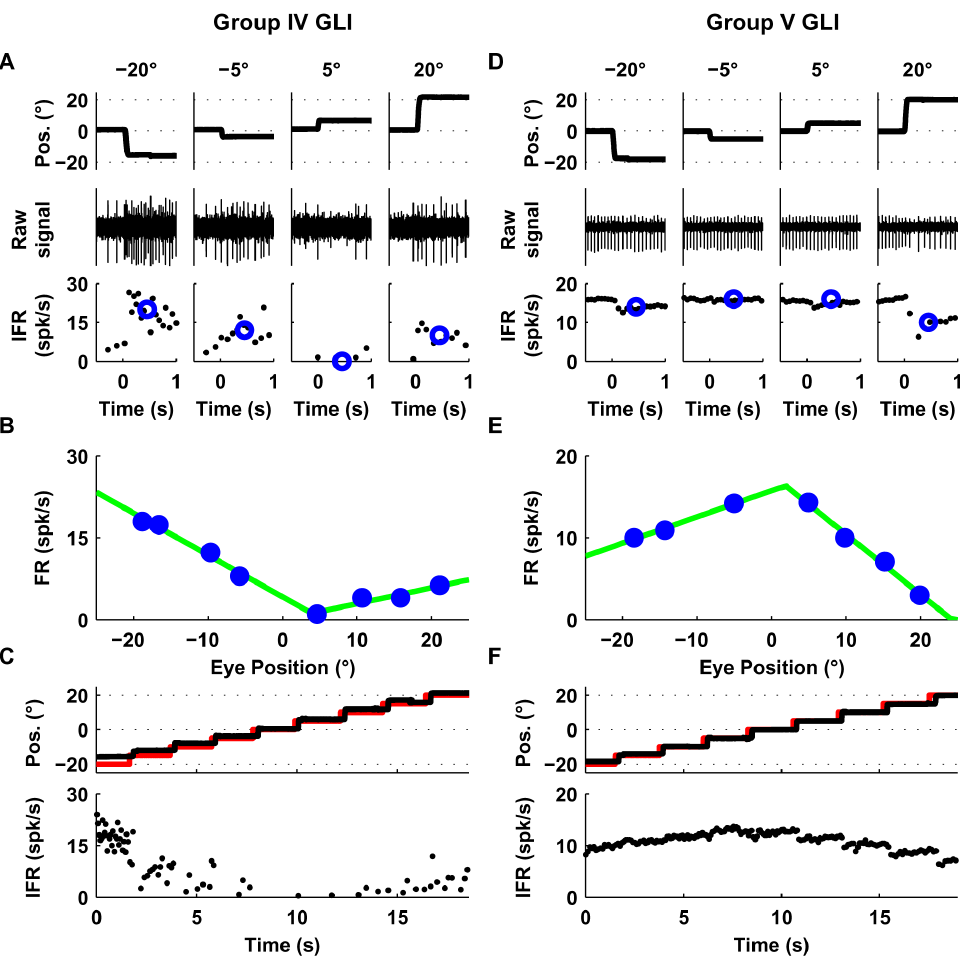
Figure 5. Responses of example Group IV (A–C) and V (D–F) GLIs. This figure uses the same layout as Figure 4A–F. ( A, D ) The upper row shows horizontal eye position, the middle raw spike data, and the bottom row instantaneous firing rate (IFR). Blue circles in the lower row represent the average firing rate following each saccade (200–700 ms). ( B, E ) Relationship between average firing rate and eye position using data from trials like those shown in A and D. Both cells were fit with the function F 3 . The corresponding fits are shown as green lines in B and E. ( C, F ) Response of the each example neuron during sequential saccades (5 deg). The upper row shows in black traces the eye position and in red traces the laser position; the lower row shows the instantaneous firing rate